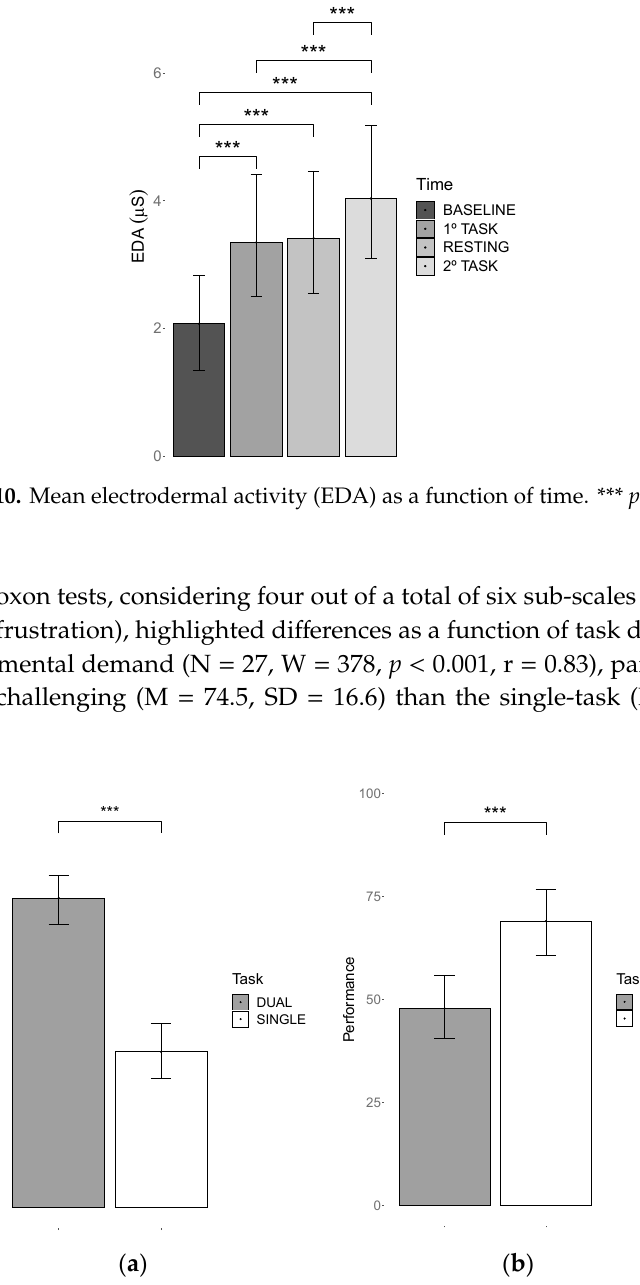
( b ) Figure 12. ( a ) Mean perceived effort and ( b ) perceived frustration as a function of task difficulty. *** p < 0.001. Finally, participants experienced a different level of frustration considering the difficulty of the tasks (N = 26, W = 322.5, p < 0.001; r = 0.68). Participants assigned a higher level of frustration to the dual-task (M = 60.67, SD = 27.16) than to the single-task (M = 33.5, SD = 25.90; see Figure 12b).